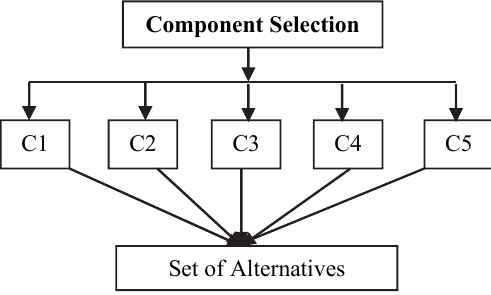
Fig. 2. Criteria based component selection